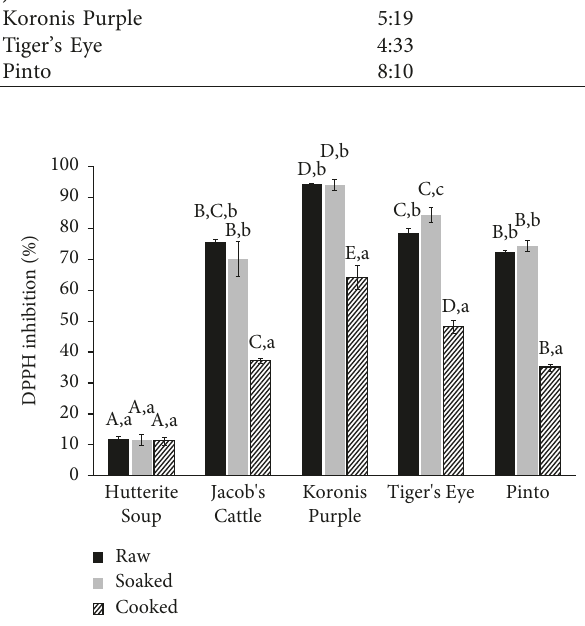
Figure 2: DPPH inhibition for raw, soaked, and cooked beans. For each type of bean, bars with different small letters indicate sig- nificant differences (LSD; P < 0 . 05). For each type of treatment (raw/untreated, soaking, and cooking), bars with different capital letters indicate significant differences (LSD; P < 0 . 05).